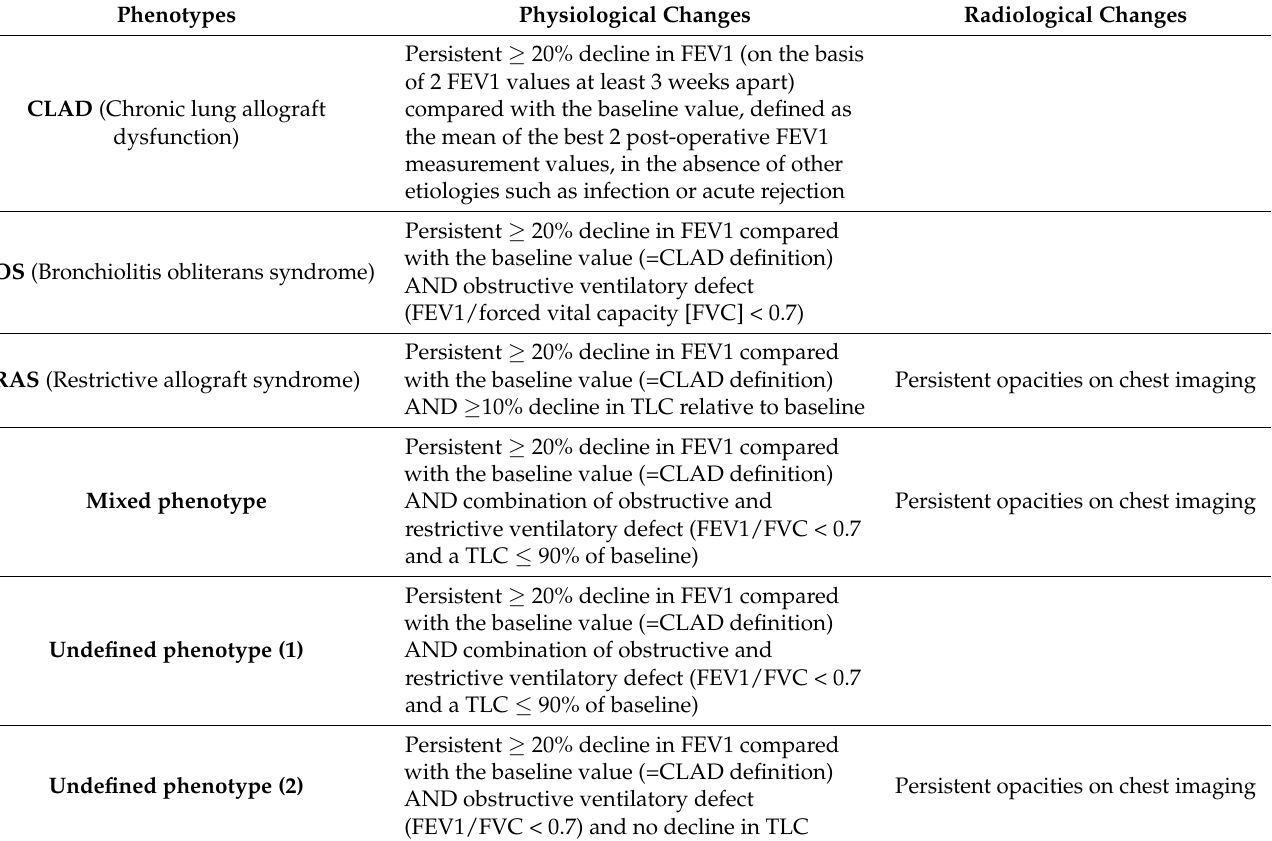
Table 1. Definition of different CLAD